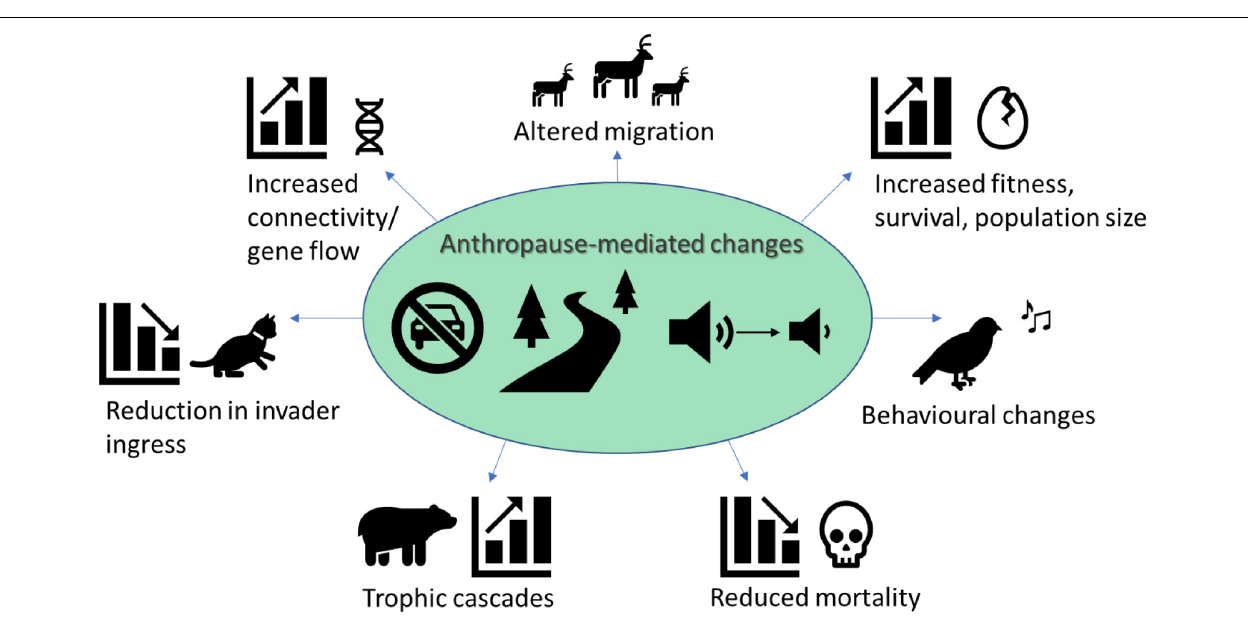
could be expected to reduce because even low concentrations of contaminants (associated with vehicle tires) can cause significant die-offs in fish (Tian et al.,